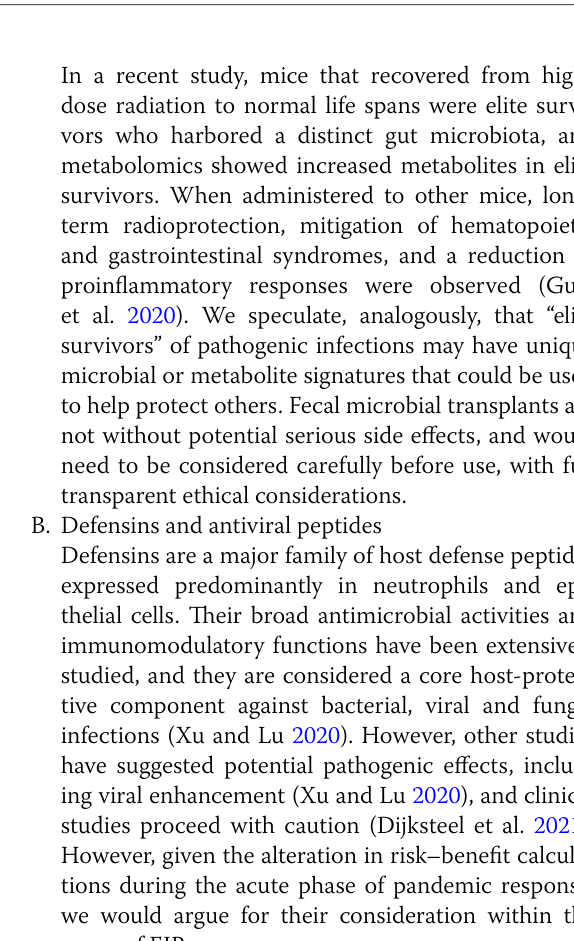
Fig. 1 Extreme immunotherpies for pandemics